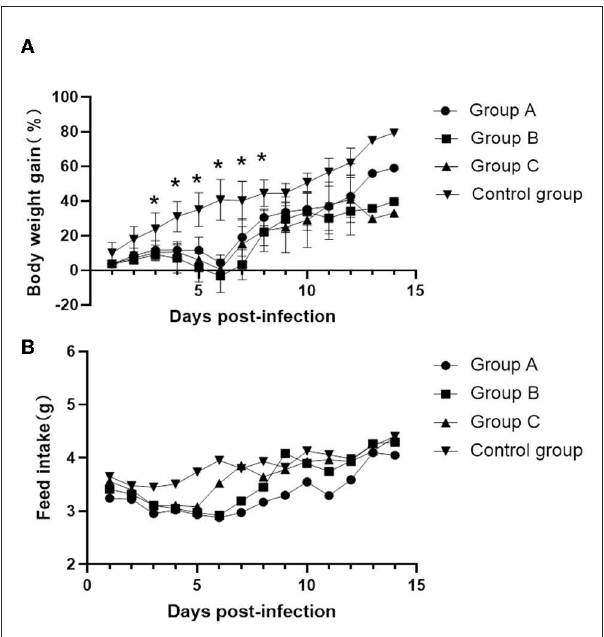
FIGURE2 Changes in body weight gain and food intake of mice at different times after inoculation. (A) Daily weight gain. (B) Feed intake. Values are mean ± SD. * P < 0.05 (by one-way